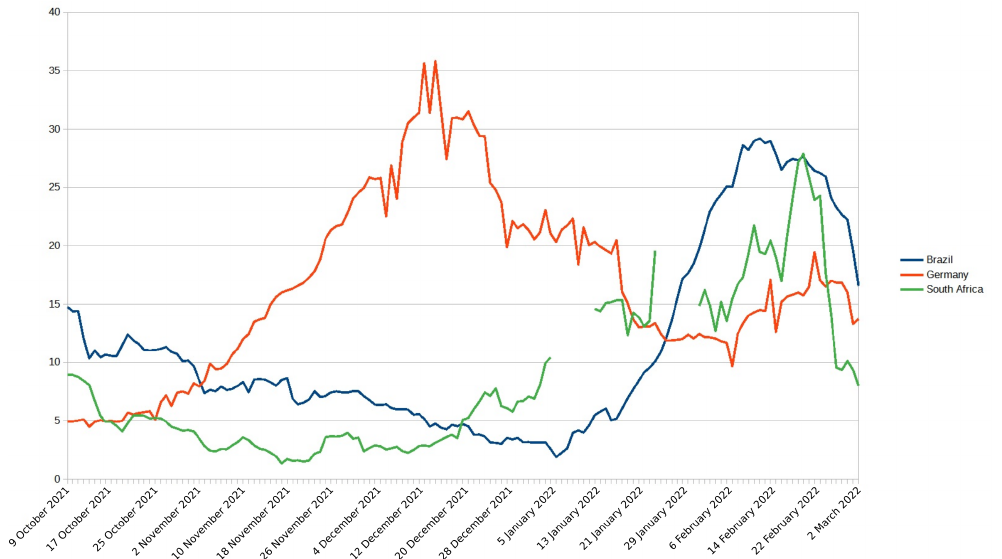
Figure 1. Weekly deaths per million people in recent since 9 October 2021 in South Africa, Germany, and Brazil. Each point represents the cumulative number of confirmed deaths over the previous week. By 15 February 2022, 4.28 billion people were fully vaccinated with the prescribed ini- tial vaccination protocol, approximately 54% of the global population. Considering the same date, in Brazil, the number of people fully vaccinated is 152.58 million, 71.26% of its popu- lation; in South Africa, the number of people fully vaccinated is 17.38 million, 28.95% of its population; and in Germany, the number of people fully vaccinated is 62.32 million people, 74.29% of its population (available at https://ourworldindata.org/covid-vaccinations, accessed on 15 February 2022).